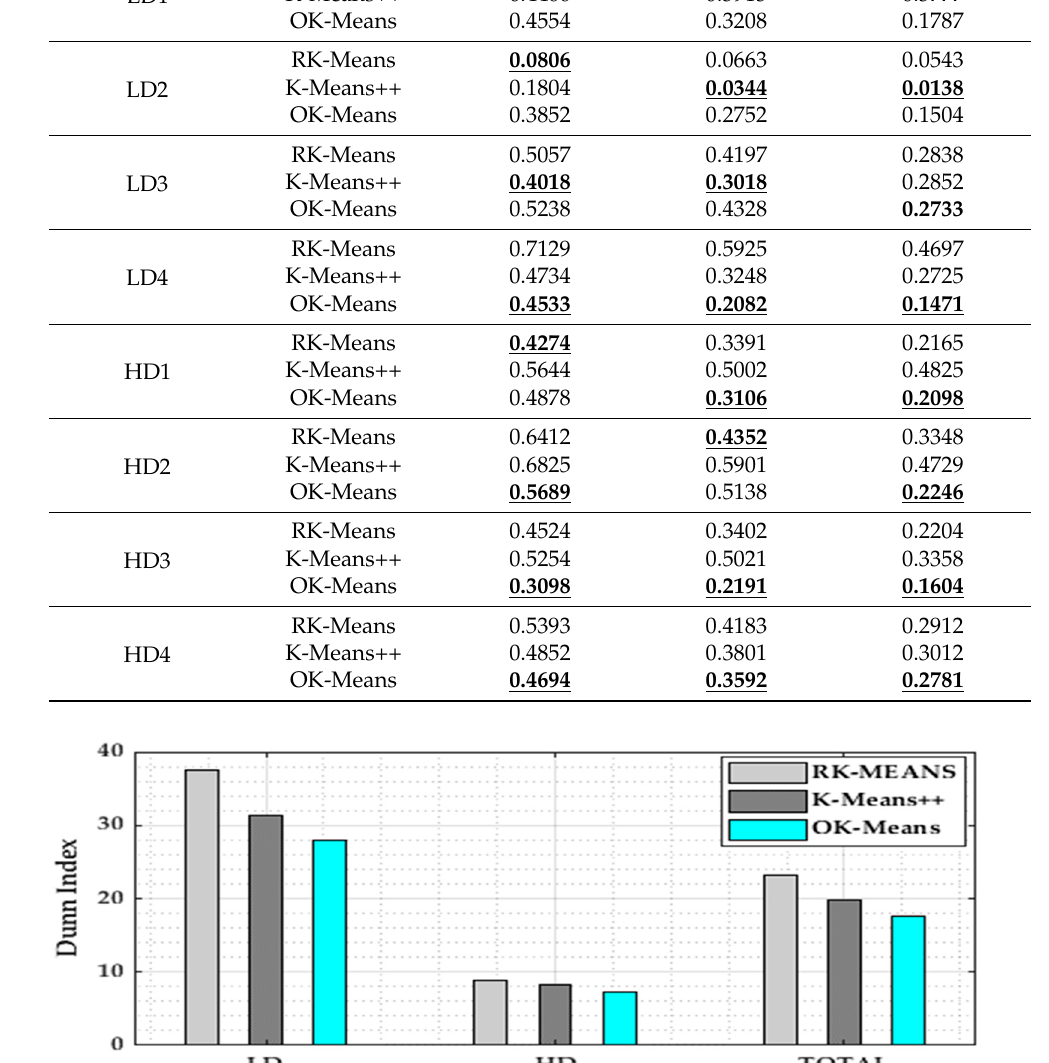
Figure 15. DI comparison results.